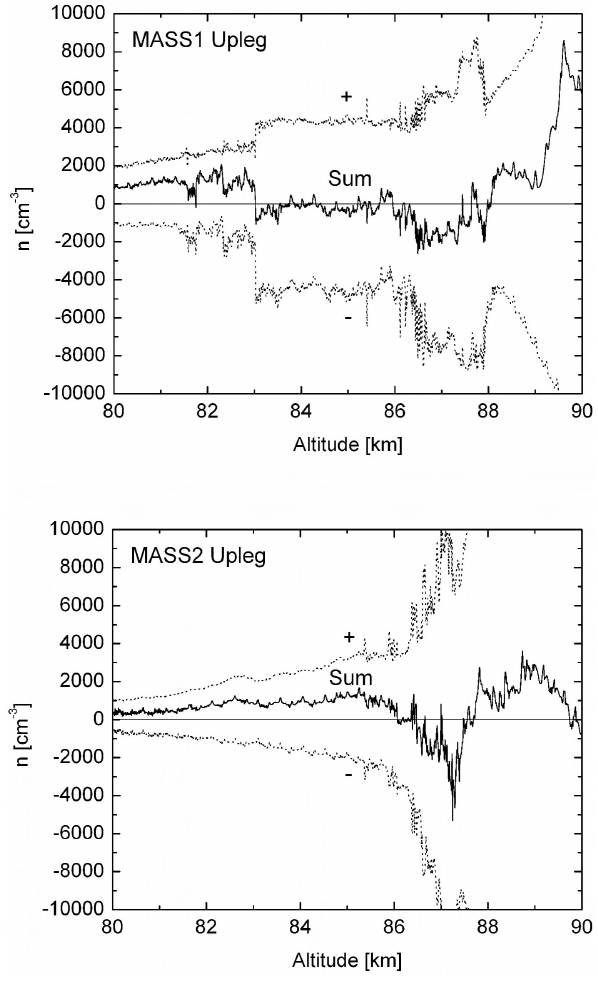
Fig. 10. These plots show, for the upleg and downleg of MASS1 and MASS2, the sum of the channels with positive signals (+), the sum of the channels with negative signals ( − ) , and the sum of all channels (sum). A zero sum is consistent with all charges having been collected, which is the nearly the case for MASS1 upleg from 83 to